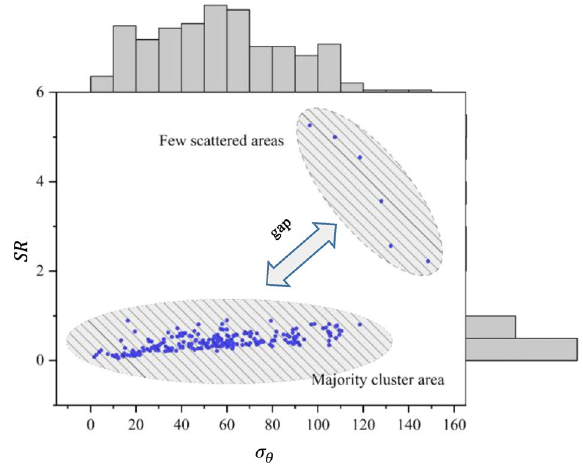
Figure 3. Unscaled data features.